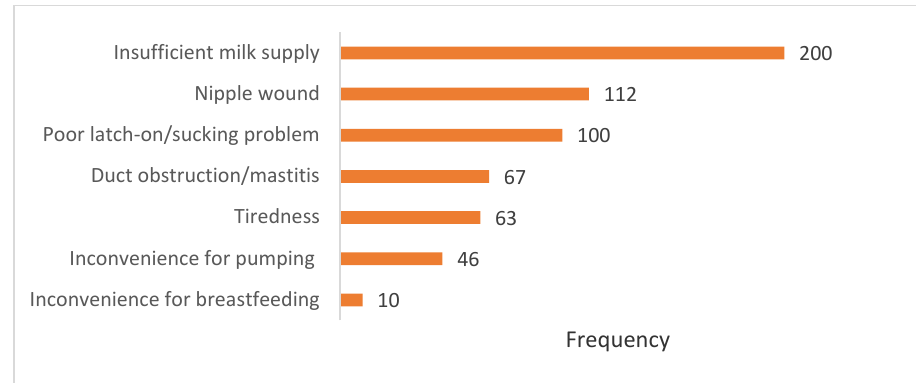
Figure 4. Breastfeeding problems .